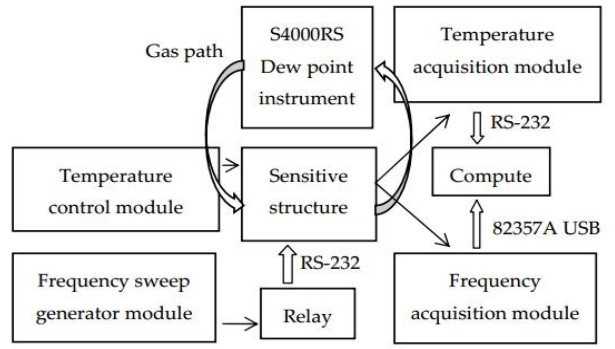
Figure 2. Experimental set-up.